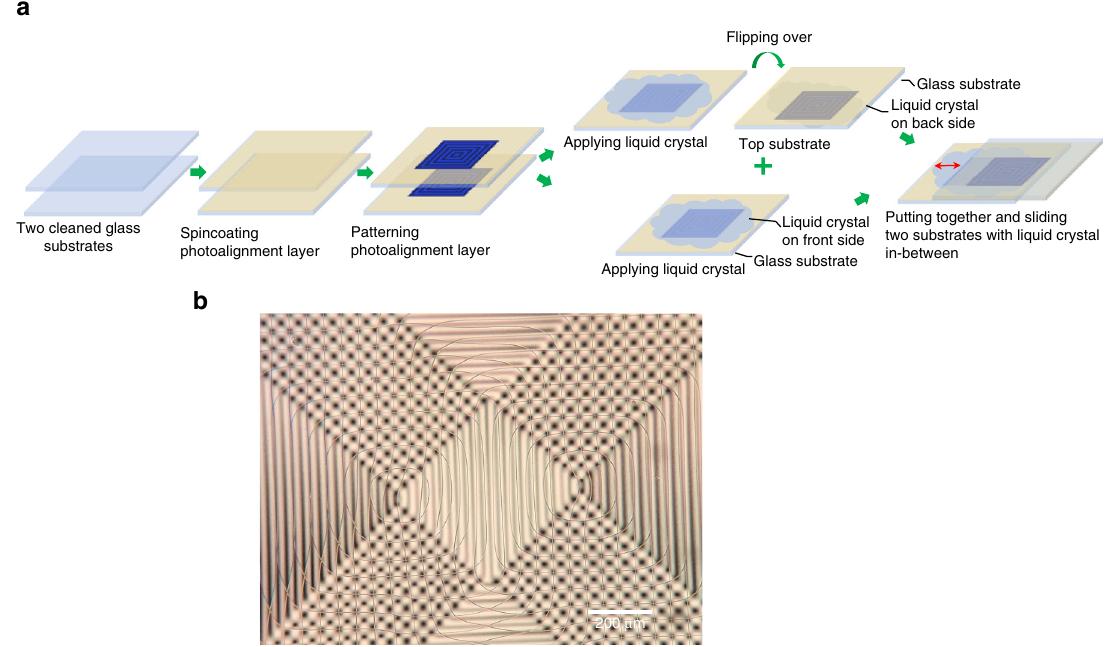
Fig. 3 Preparation steps and the polarized micrograph of assembled sliding cell. a Preparation steps of patterned photoalignment cell with sliding substrates. b Polarzied optical micrograph of the assembled cell immediately after the top substrate was slid to form the desired con fi guration of overlapped photoalignment patterns. The lack of coloration indicates the thickness of the liquid crystal layer is still larger than 30 μ m. The disclination lines in the central rectangle are still intact, which begin to annihilate as the LC layer thins. The disclination lines are more susceptible to bending in a thick LC layer than at later stages with a thinner LC layer, generally due to the weakening of some of the stabilizing forces with the increase in the